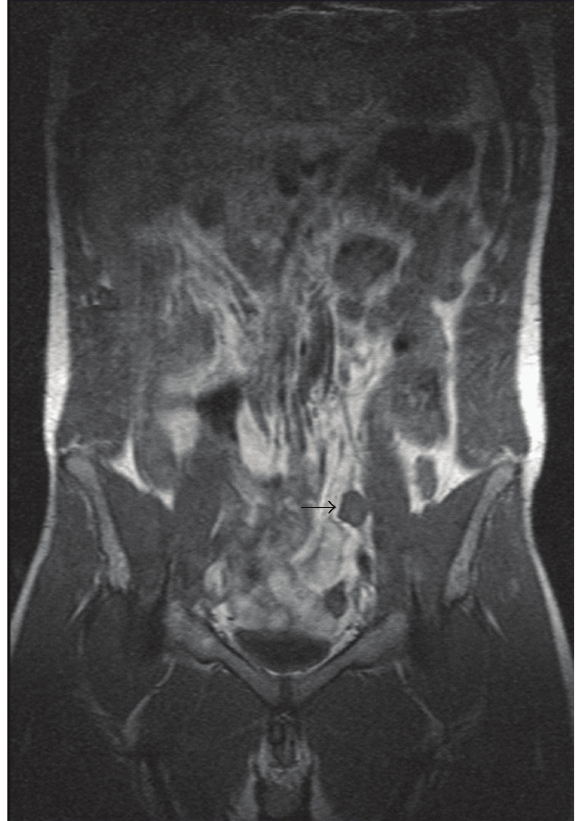
Figure 1: Coronal magnetic resonance imaging scan demonstrating 30mm left renal mass (arrow).